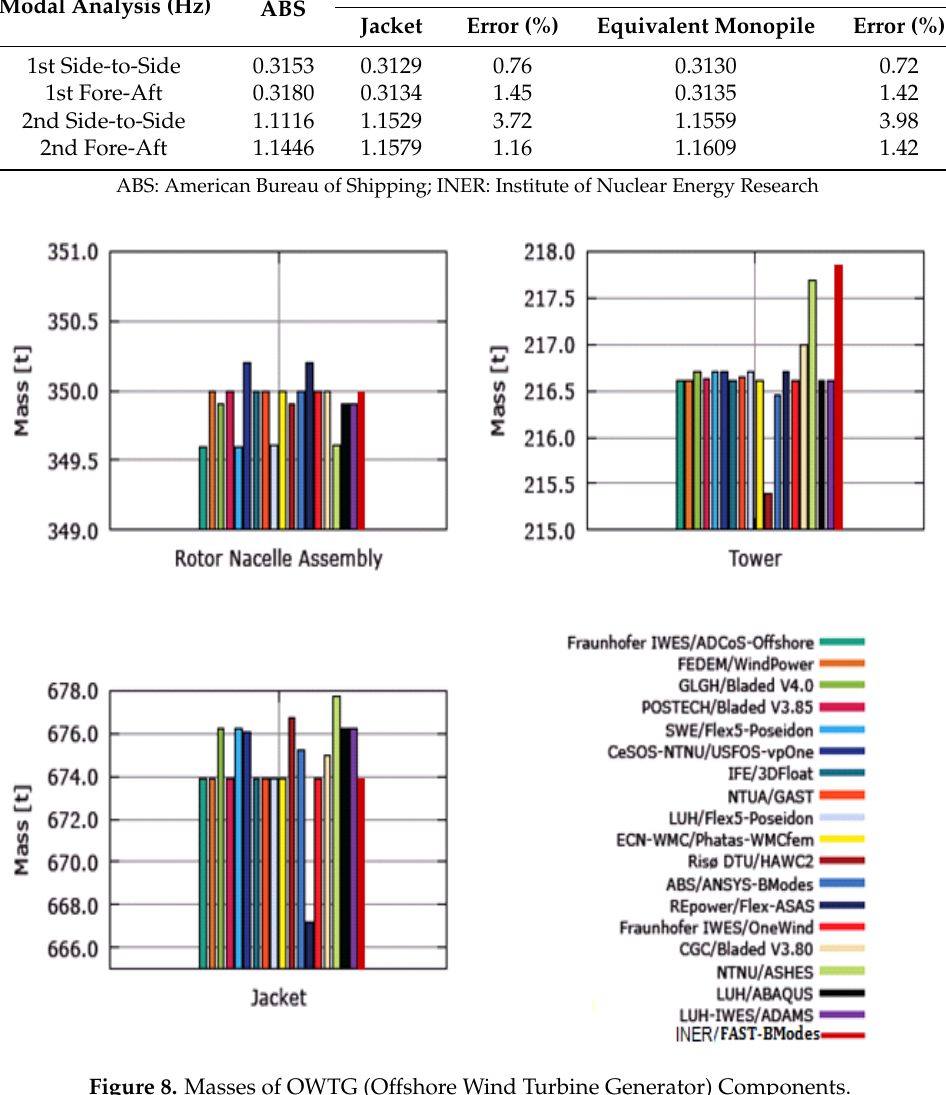
Figure 9. Growth Mass ( a ); and Flooded Legs ( b ).